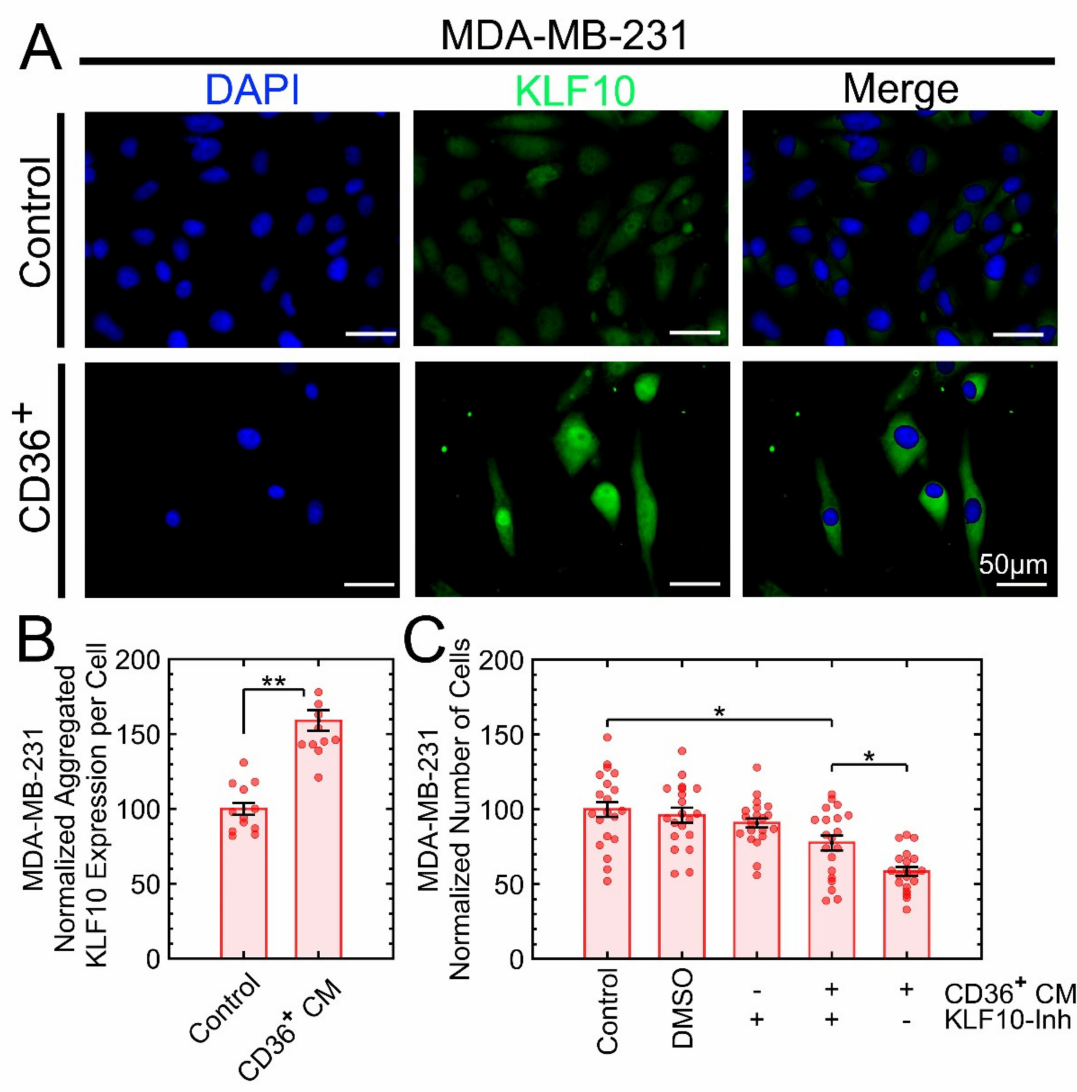
Figure 9. Overexpression of the KLF10 transcription factor is one of the mechanisms for growth suppression in MDA-MB- 231 as a result of exposure to the CM of CD36 + FBs. ( A ) DAPI and KLF10 staining for control and treatment were monitored with fluorescent microscopy. ( B ) Quantitative analysis indicated overexpression of KLF10 with the treatment. ( C ) A control experiment to validate reduced growth suppression by adding the KLF10-inhibitor to the CM of CD36 + FBs. * p < 0.05, ** p <